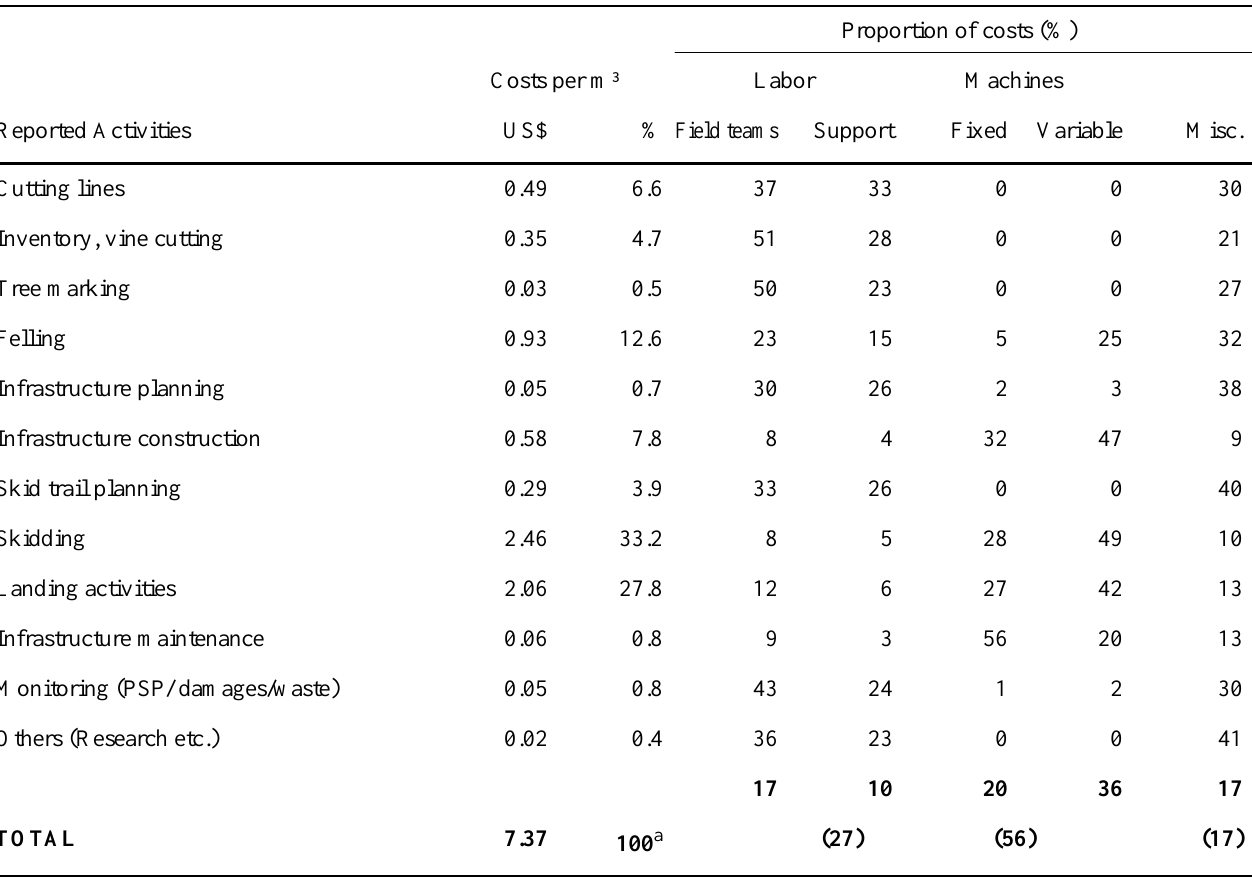
Table 6 . Average harvesting cost per m³ of round wood and the participation of different cost types (without transport and